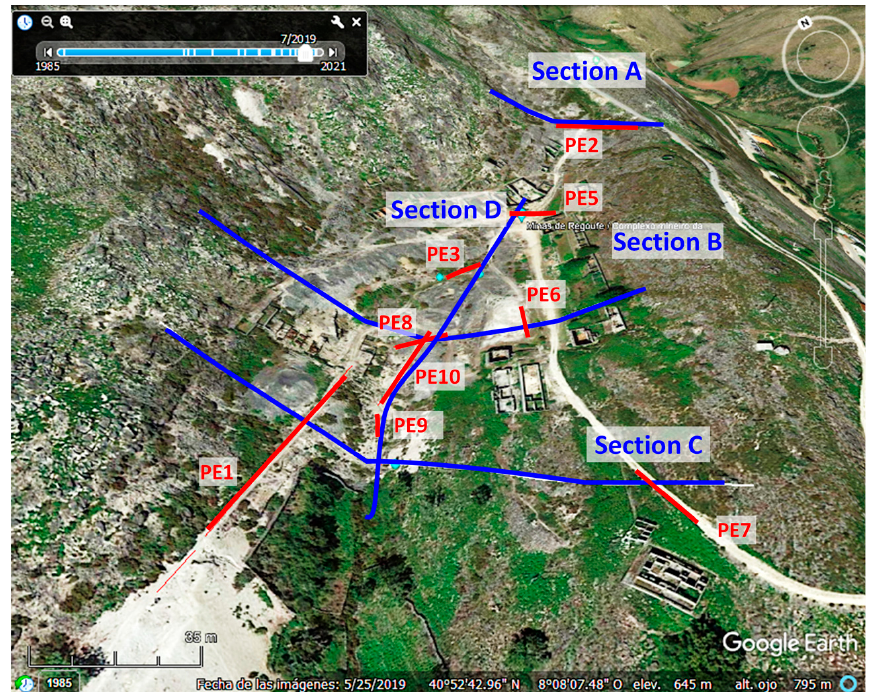
Figure 11. Location of hydrogeological sections and electrical profiles in a 3D overview with aerial photography extracted from Google